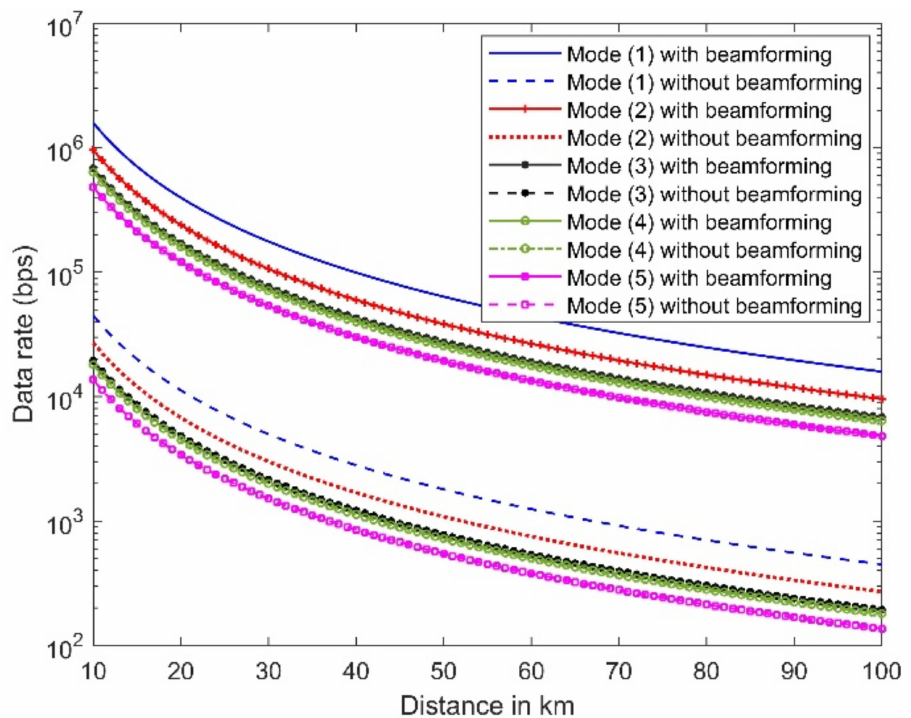
Figure 30. The estimated data rate versus distance corresponds to five communication scheme modes with and without the use of